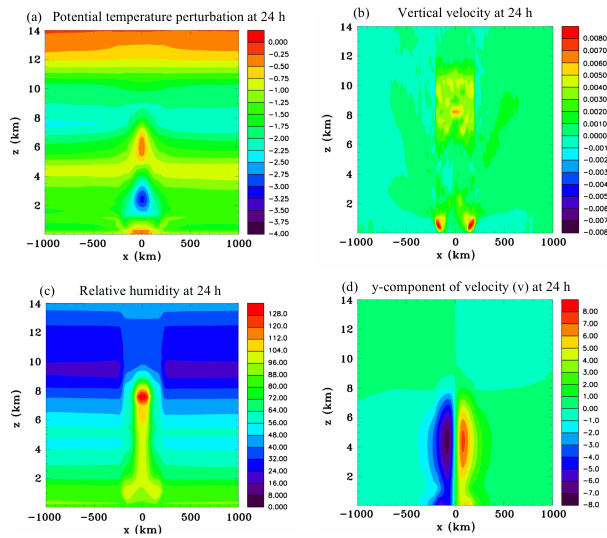
Figure 19. Vertical sections for Experiment 12: the radiation scheme activated in the environment, r > 200km. (a) Potential tem- perature perturbation (K), (b) vertical velocity (ms − 1 ), (c) relative humidity, and (d) y -component of velocity, v (ms − 1 ), at t = 24h.